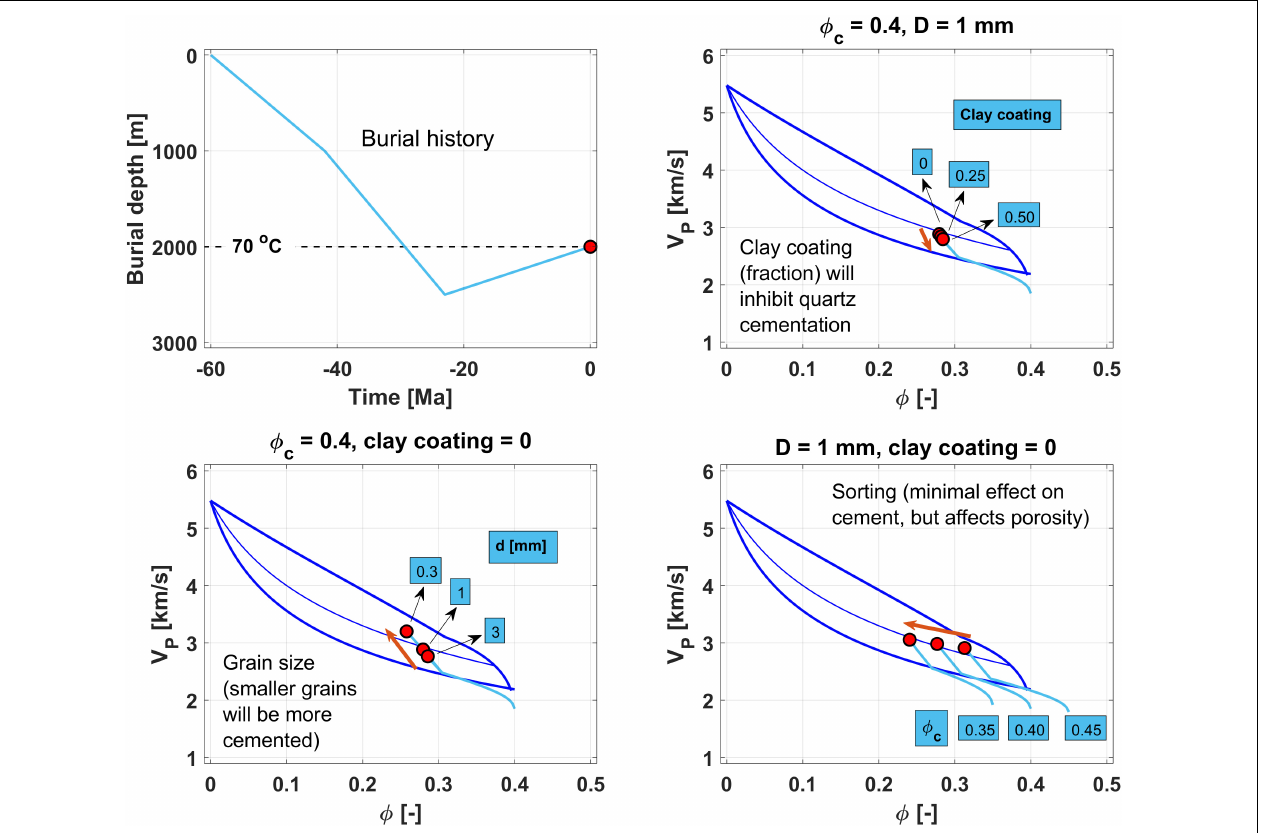
FIGURE 2 | Combined burial (mechanical and chemical compaction) and rock physics modeling using contact theory. The end-points in red represent the present-day properties, whereas the light blue curves show the rock physics properties as a function of geological time. The modeled rock represents a Tertiary age sandstone deposited 60 Ma ago that reached the chemical compaction domain ( > 70 ◦ C) around 30 Ma ago, then maximum burial around 25 Ma ago before the rock was exposed to tectonic uplift (which would also erode a significant part of the overburden) and is presently buried at 2 km beneath the sedimentary surface. The various subplots show the combined burial and rock physics modeling sensitivity to various input geological parameters, comprising clay coating, grain size (D), and sorting (via varying critical